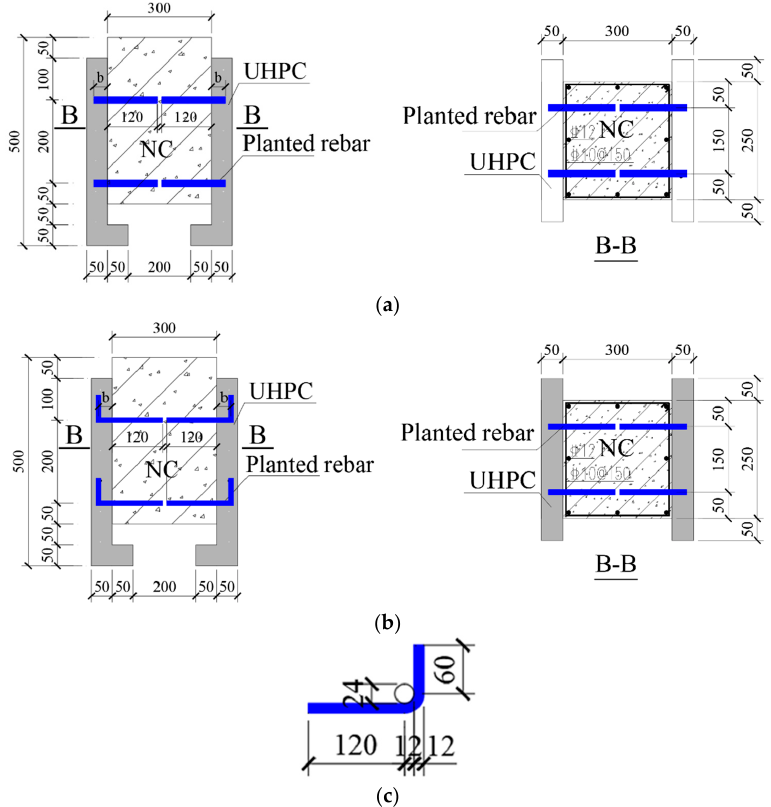
Figure 1. Configurations of the UHPC–NC push-out test specimens. ( a ) fabrication of planting rebars (straight); ( b ) fabrication of planting rebars (hooked); ( c ) hooked rebar.